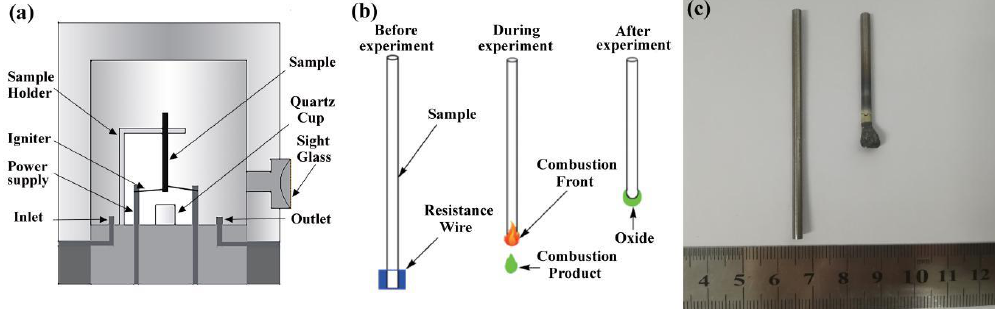
Figure 1. ( a ) Promoted ignition-combustion testing equipment, ( b ) Schematic diagram of ignition combustion samples, ( c ) samples after combustion.